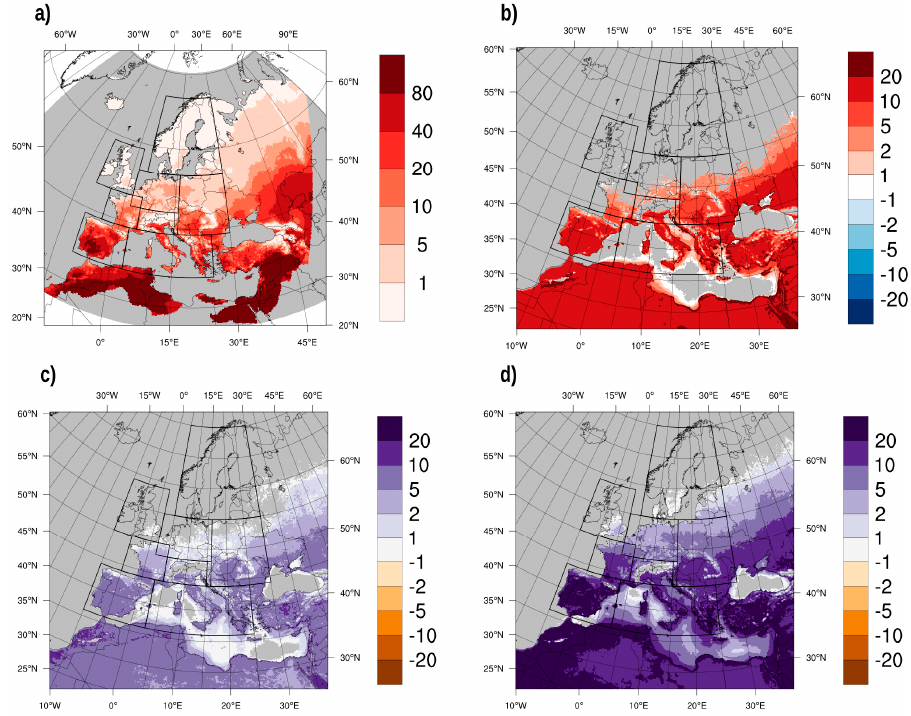
Figure 1. Hot days per year and its climate change signals under different global warming levels (GWLs): ( a ) The upper left panel shows the number of hot days for present day climate conditions using E-OBS observation data. ( b ) The upper right panel shows the climate change signal for hot days under +1.5 °C GWL. The lower left ( c ) and right ( d ) panel show the difference between the climate change signals for a +2.0 °C GWL and a +3.0 °C GWL in comparison to the climate change signal under +1.5 °C GWL for hot days, respectively. They are thus showing the additional projected climate change which can be avoided when sticking to +1.5 °C. All climate change signals are shown for significant values only. Non-significant values are depicted in gray, except for E-OBS (plot a), where non-land areas, in which no data is available, are depicted in gray.